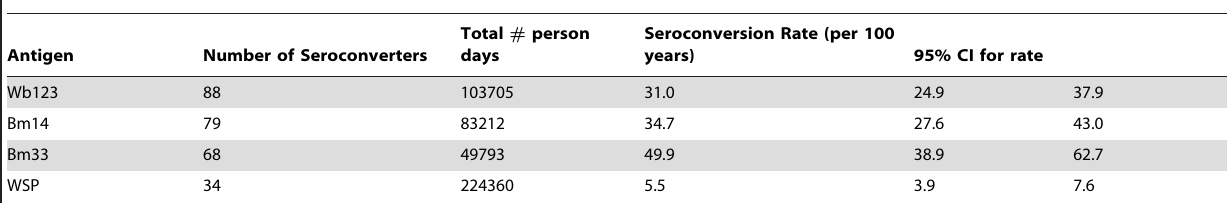
Table 3. Seroconversion rates by antigen.